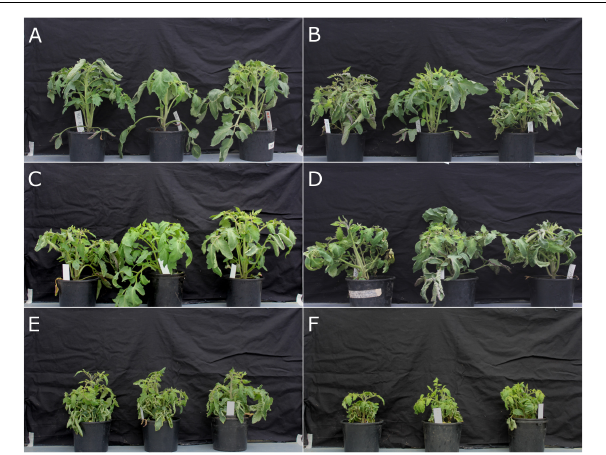
FIGURE 1 | Fusarium wilt disease assay on rmc and 76R tomatoes confirming rmc as more susceptible to Fusarium oxysporum f. sp. lycopersici ( Fol ) race 3 than 76R. (A) Tomato 76R and (B) rmc were inoculated with Fol race 1; (C,D) 76R and rmc were inoculated with Fol race 2; (E,F) 76R and rmc were inoculated with Fol race 3. Plants were inoculated using a root dip method and photographed 3 weeks after inoculation.